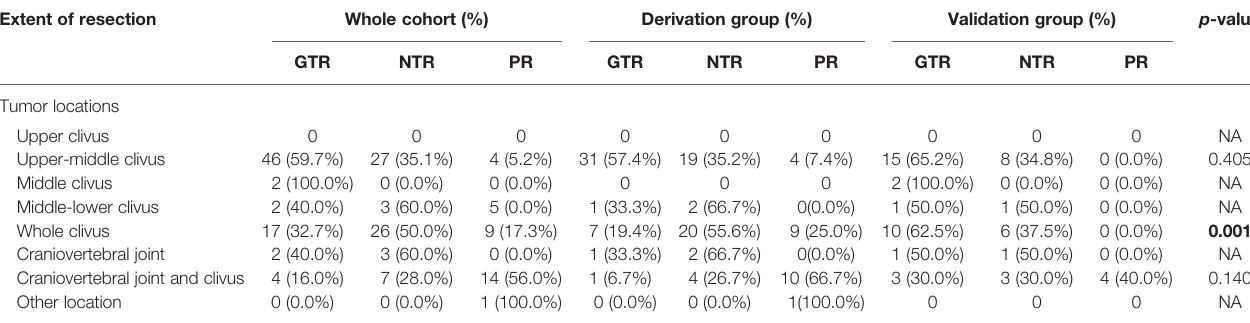
TABLE 4 | Extent of resection of skull base chordoma in different locations between the two groups. Extent of resection